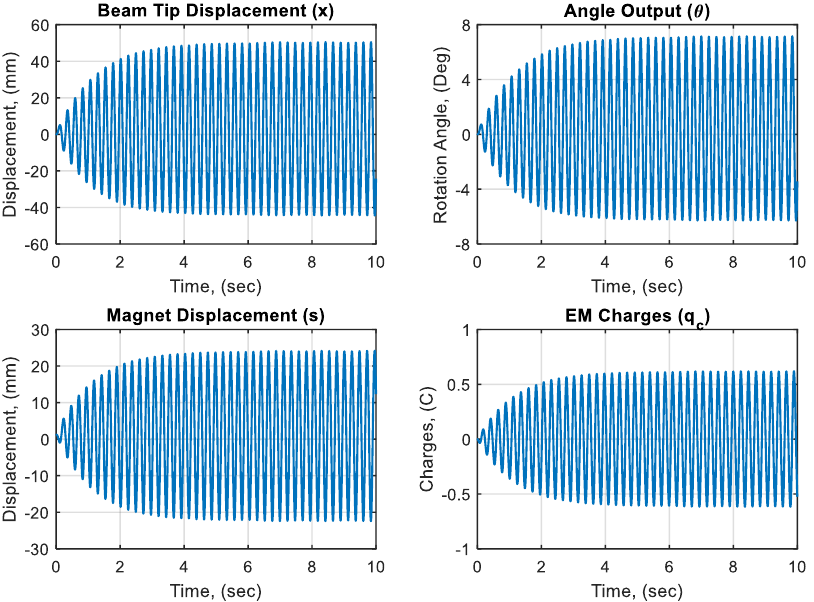
Figure 5. Time history plots of the four generalized coordinates of the turbine at a wind speed ( U f ) of 4.22 m/s and a spring stiffness ( k 2 ) of 2034 N/m.